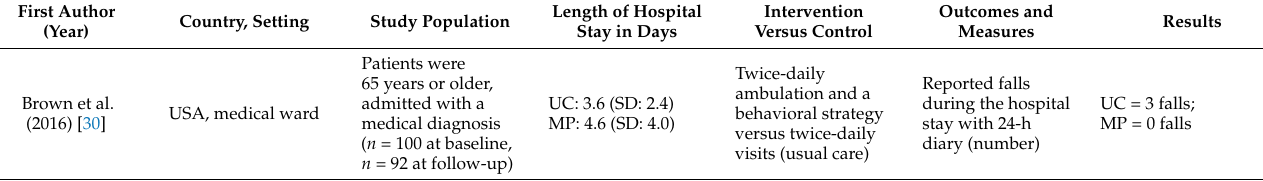
Table 1. Study characteristics, population, intervention versus control, and